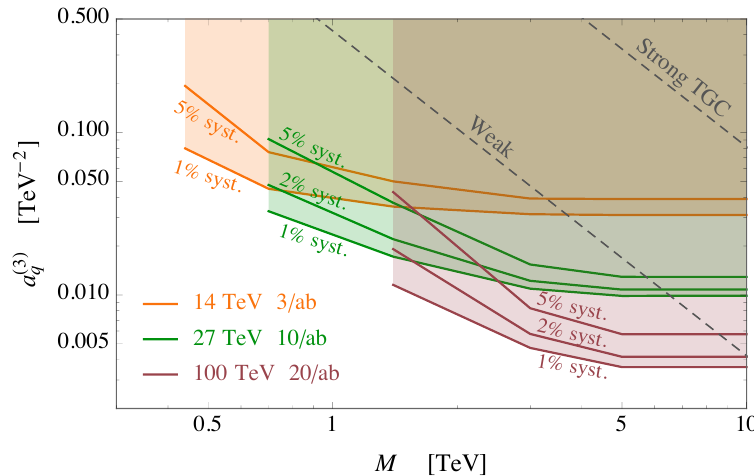
Figure 6 . Expected 95% CL bounds from fully leptonic WZ on the high-energy primary parameter a (3) q as a function of the new physics scale M . The plots reports the results for the HL-LHC (orange lines), HE-LHC (green lines) and FCC-hh (brown lines) for di(cid:11)erent values of the systematic